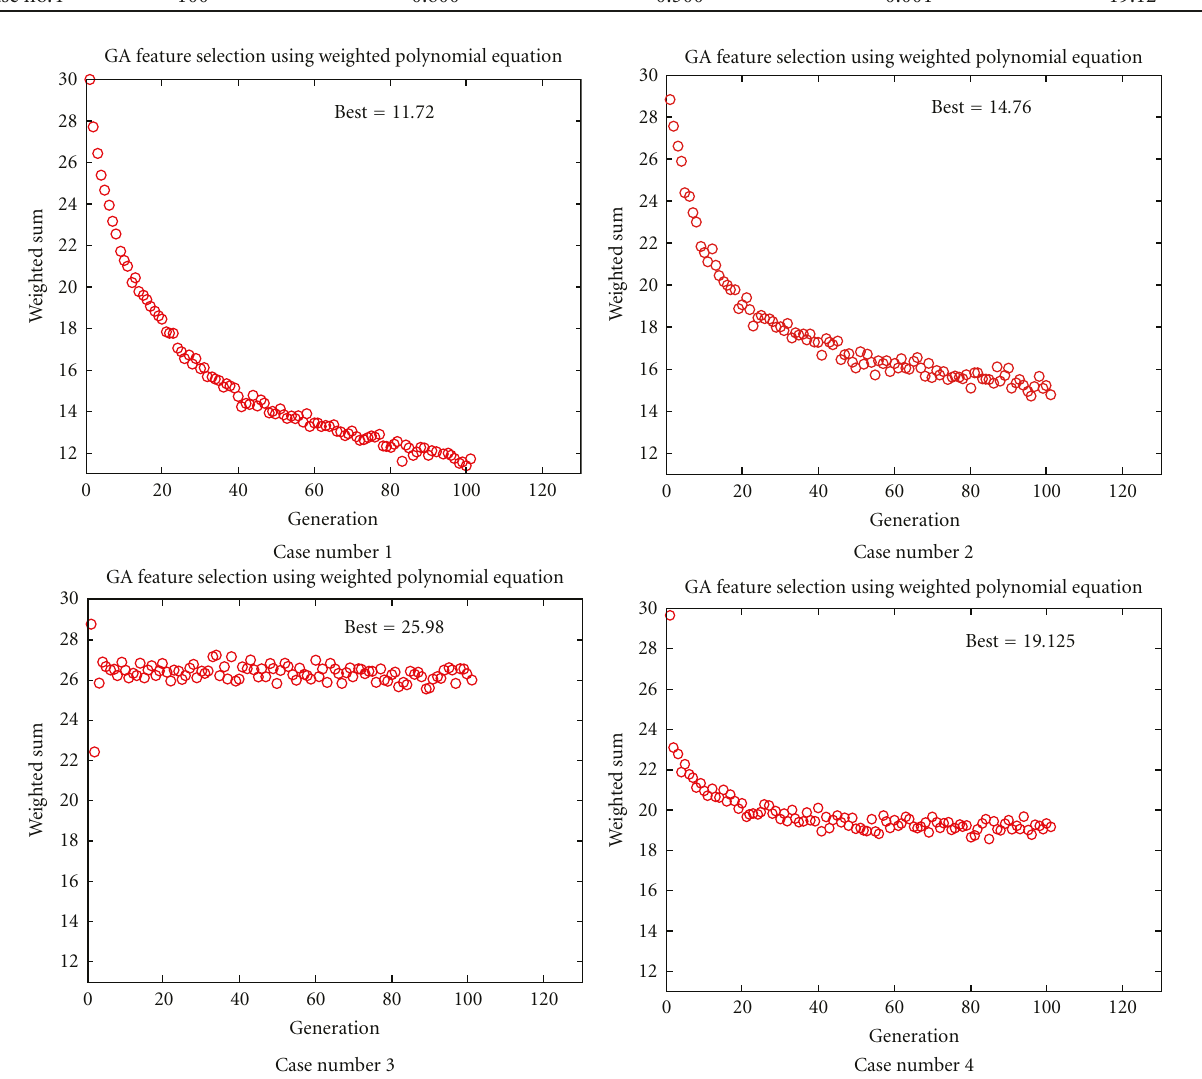
Figure 4: Evolutionary process according to preliminary test